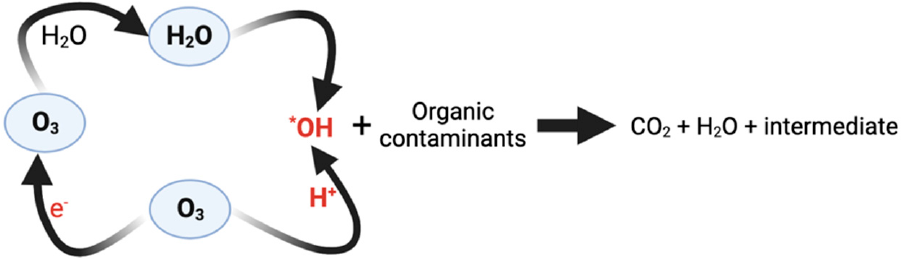
Figure 2. Mechanism of organic contaminant mineralization by ozonation (modified from [49], and permission for re-using the figure was received on 14 August 2022 from Elsevier).